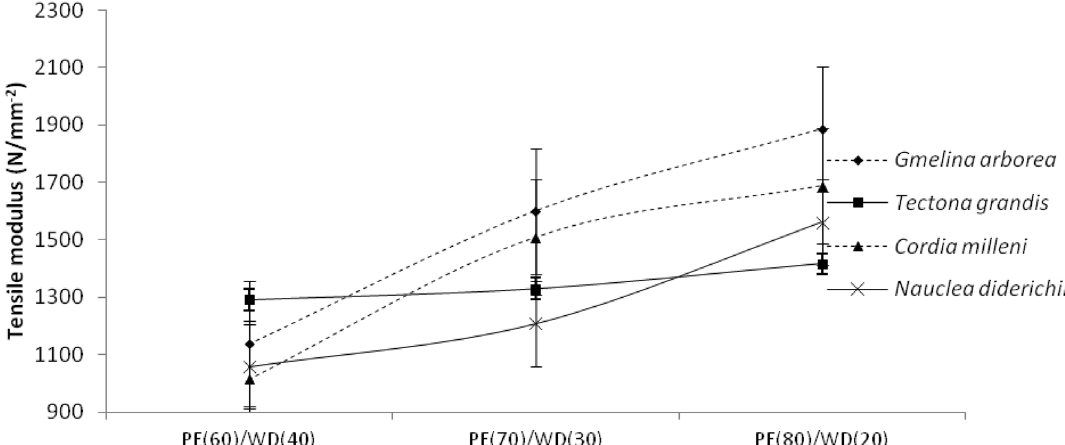
Figure 7. Tensile modulus of extruded-compressed biopolymer composites.